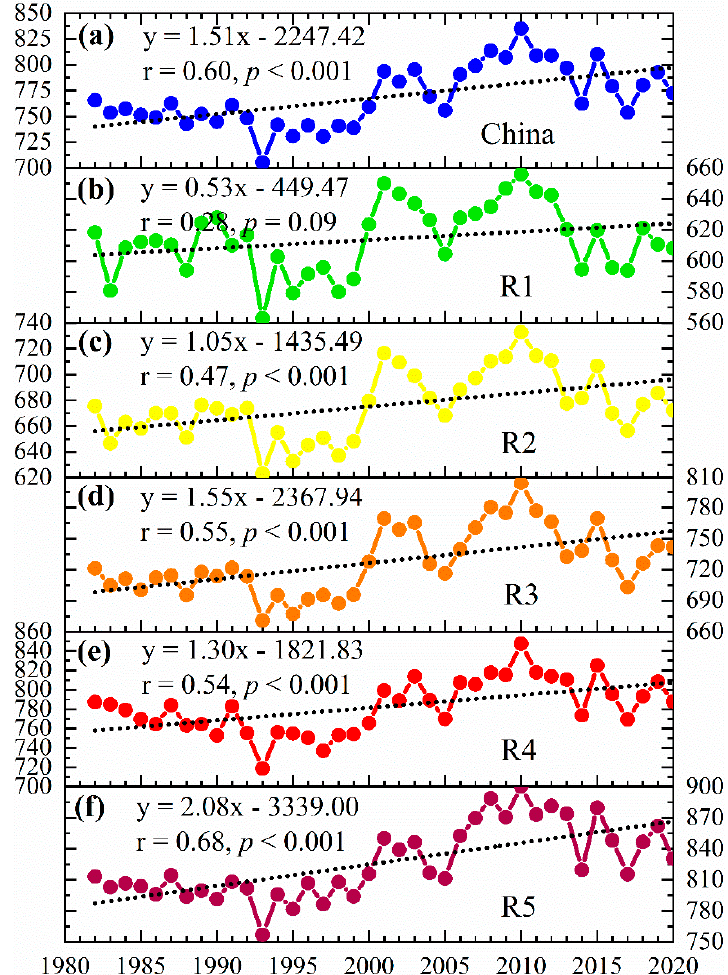
Figure 3. Annual variation in OMR in different ozone pollution regions from 1982 to 2020. The unit is kg/kg. To accurately detect the variation in OMR, all OMR were multiplied by 1 × 109 to amplify the variation of small signals. ( a ) is annual variation in OMR over China. ( b – f ) are annual variation in OMR over ozone pollution region of R1, R2, R3, R4 and R5, respectively.